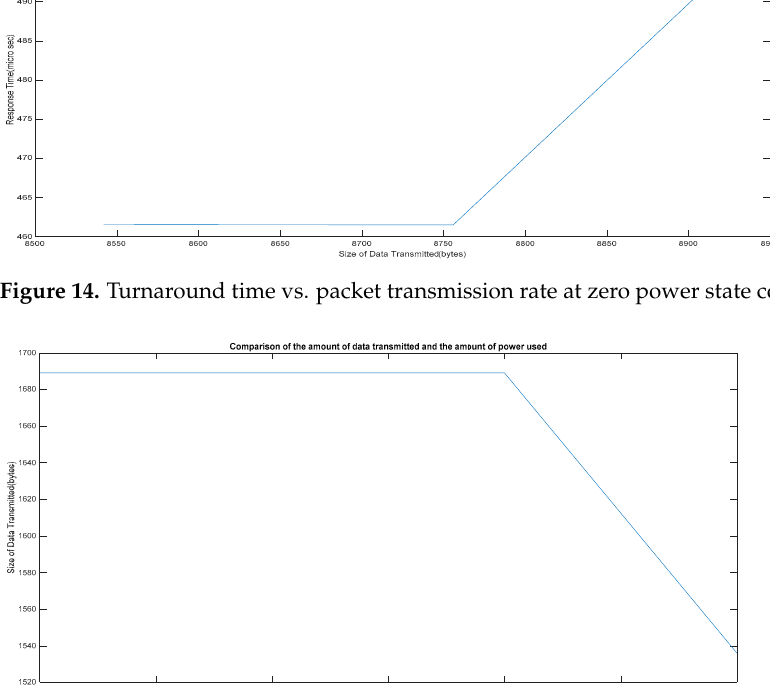
Figure 15. Comparison of the amount of data transmitted and the amount of power used.